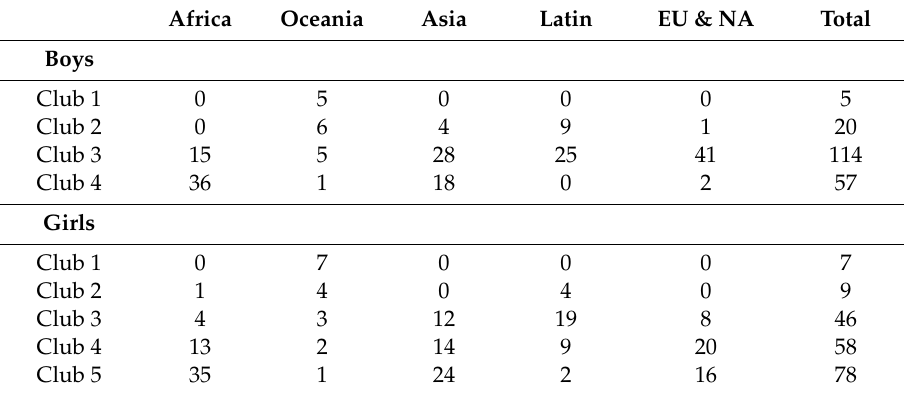
Table A1. Number of countries by Club and